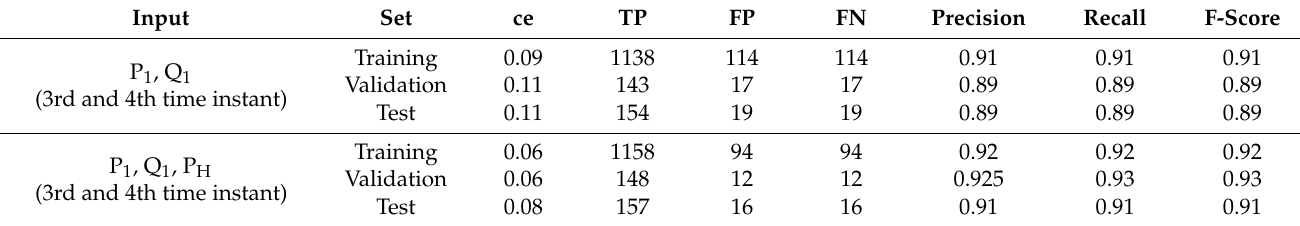
Table 5. Training, Validation and Test sets performance for additional